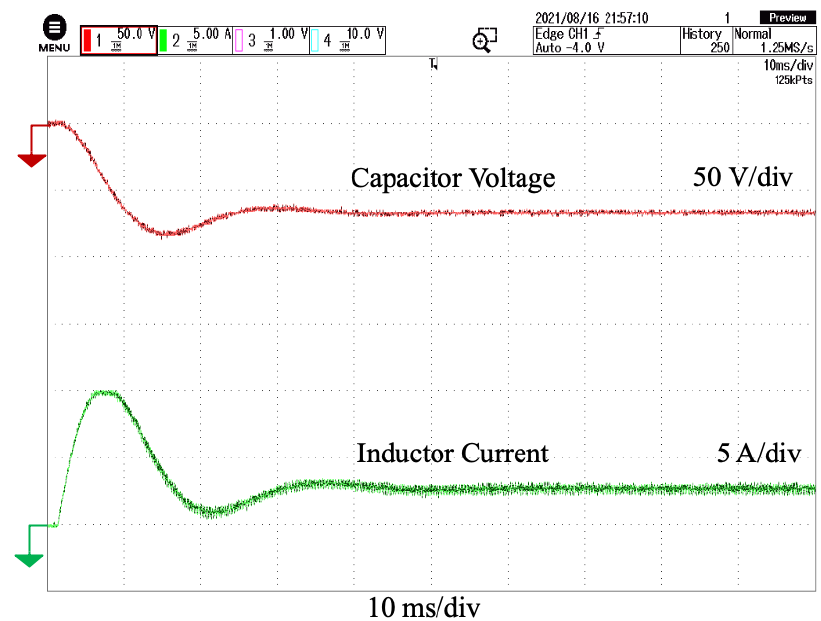
Figure 16. Experimental results of capacitor voltage and inductor current over continous time from S 4 .